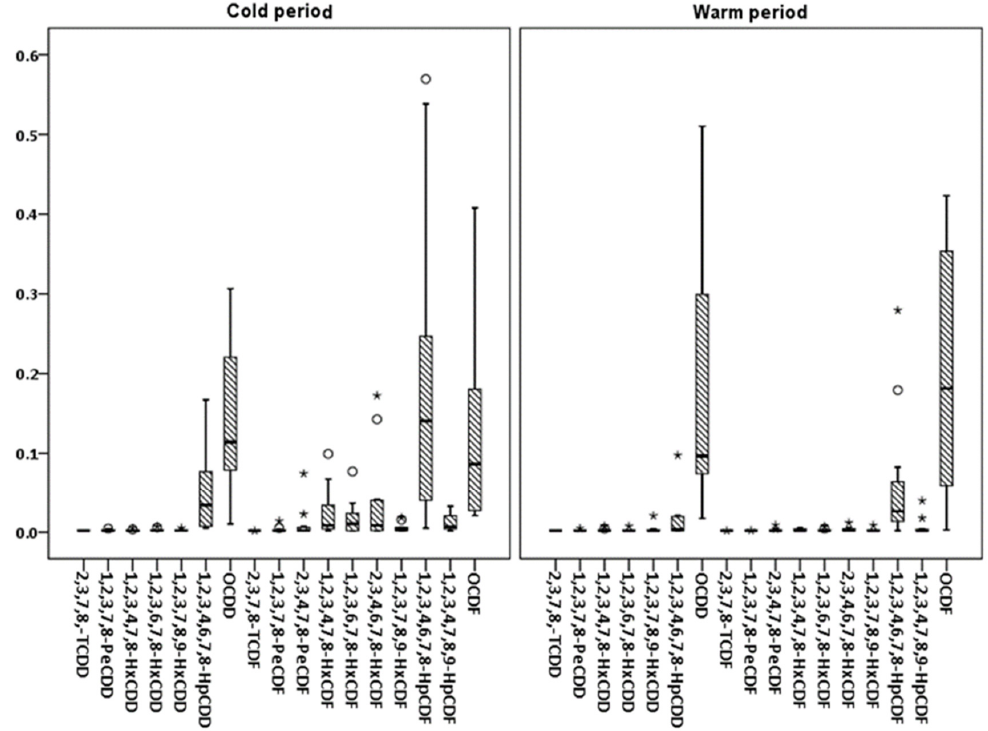
Figure 5. PCDD/F seasonal variations in pg m − 3 (* outliers and o values above 3rd quartile).